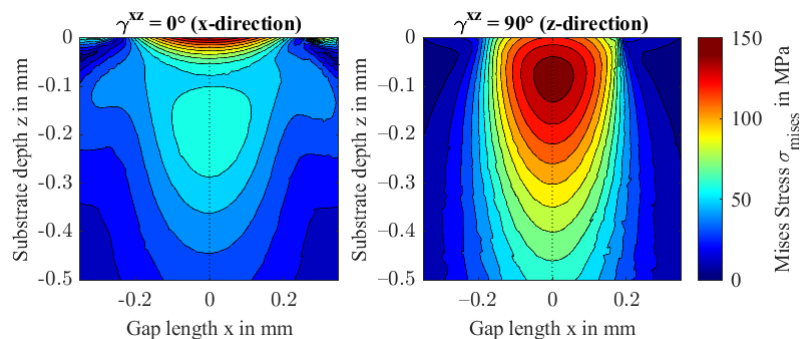
Figure A4. von Mises stresses in the xz-plane at y = 0 for 𝛾 𝑦𝑧 = 0 and 90°.